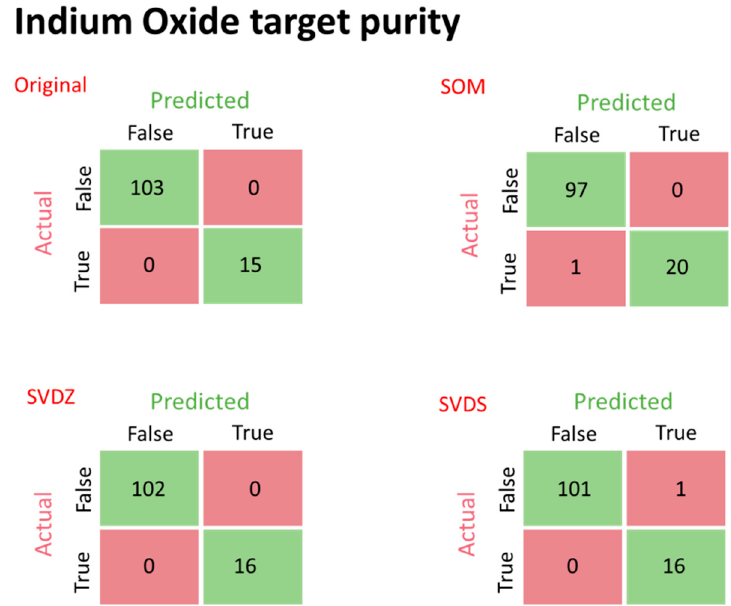
Figure 19. Confusion matrices demonstrating the accuracy of the two-dimensional generated images for training CNN model for classification of 100% purity of indium-oxide sputtering target. The SVD reconstruction of the SOM method demonstrated one inaccurate classification, while all other models performed with 100% accuracy. Table 1. Confusion matrix of model classification associated with Hydrogen presence and impurity in the indium oxide target.